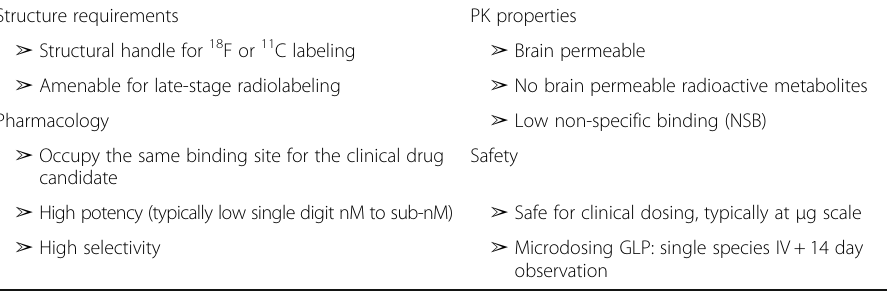
Table 1 Desired attributes for successful CNS PET ligands Structure